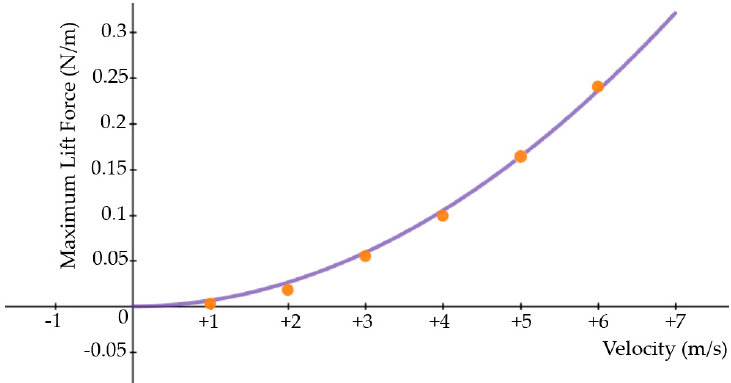
Figure 11. Curve fitting to the maximum points of lift force.